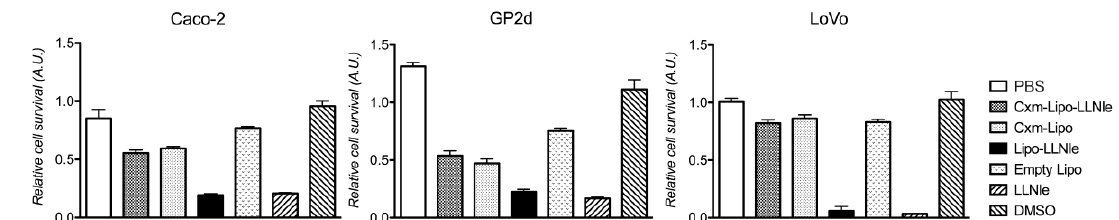
Figure 4. LLNle-liposome inhibits CRC cell line survival. MTT analysis of Caco-2, GP2d, and LoVo cell line treated with LLNle, DMSO (used as a control for LLNle), LLNle-liposomes, Cxm-liposomes-LLNle, empty liposomes, and PBS (control for liposomes) for 72 h. LLNle-liposomes were diluted to achieve an LLNle final concentration in the culture medium equivalent to 2.5, 2.0 and 0.8 µ M of free LLNle for Caco-2, GP2dandLoVo, respectively. Allmeasurementsherereportedarepresentedasmean ± standard deviations (s.d.), n = 4. Details of the results of the statistical analysis are provided in Table